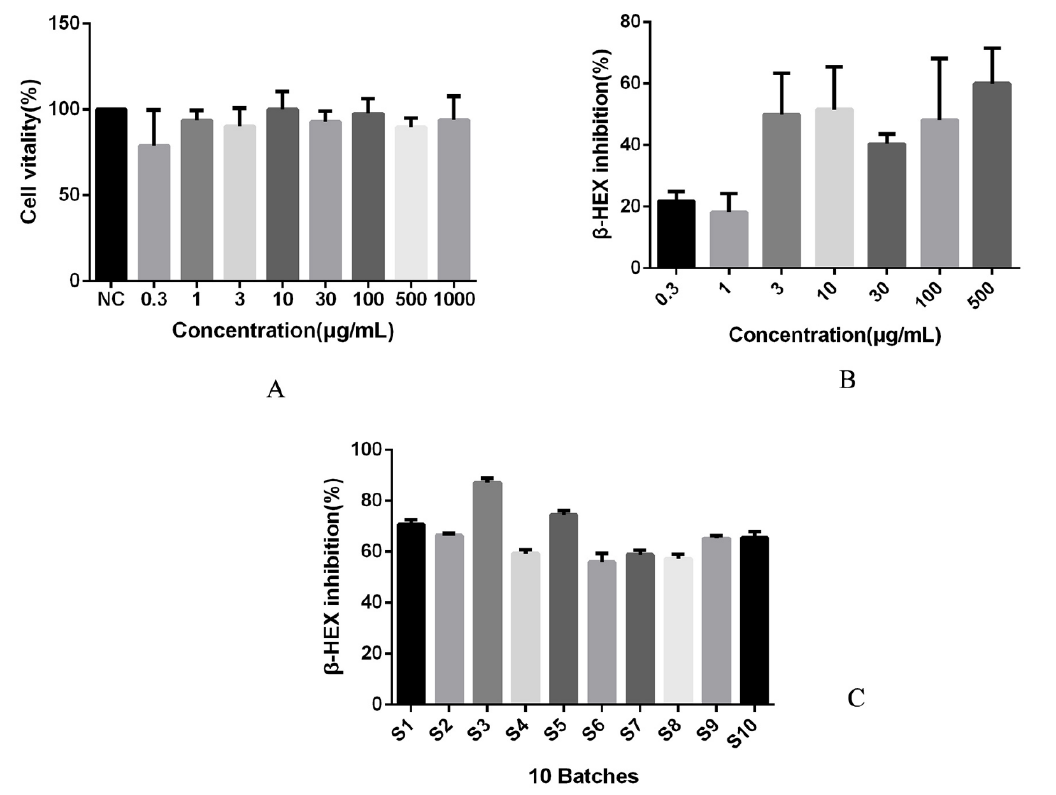
Figure 7. The effect of SPs on cell viability ( A ). The Inhibitory effect of different concentrations ( B ) and batches ( C ) of SPs on β -HEX release, the inhibition rate of the control group was zero. The effects of SPs at concentrations of 0.3, 1, 3, 10, 30, 100, and 500 µ g mL − 1 on the release of IgE-mediated degranulation of β -HEX in RBL-2H3 cells were investigated. The results showed that SPs could significantly inhibit the release of β -HEX from RBL-2H3 cells in the concentration range of 0.3~500 µ g mL − 1 , and the inhibition rates were 21.8%, 18.3%, 49.9%, 51.6%, 40.5%, 48.1%, 60.0%, respectively, as shown in Figure 7B. The